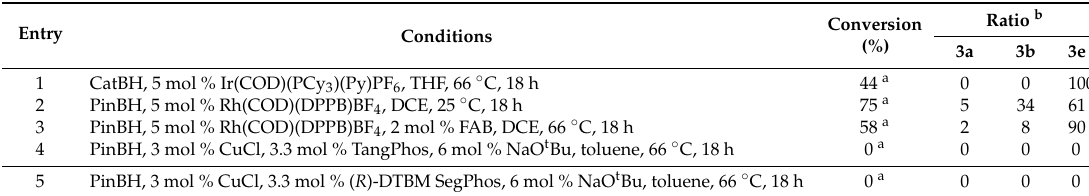
Table 2. Catalyst screen for the hydroboration of 2